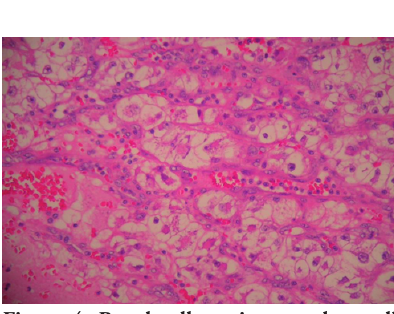
Figure 2. Computerized tomography scan of the abdomen showing a 7 cm area of enhancement in the left lower pole of the kidney (arrow) consistent with renal clear cell carcinoma.